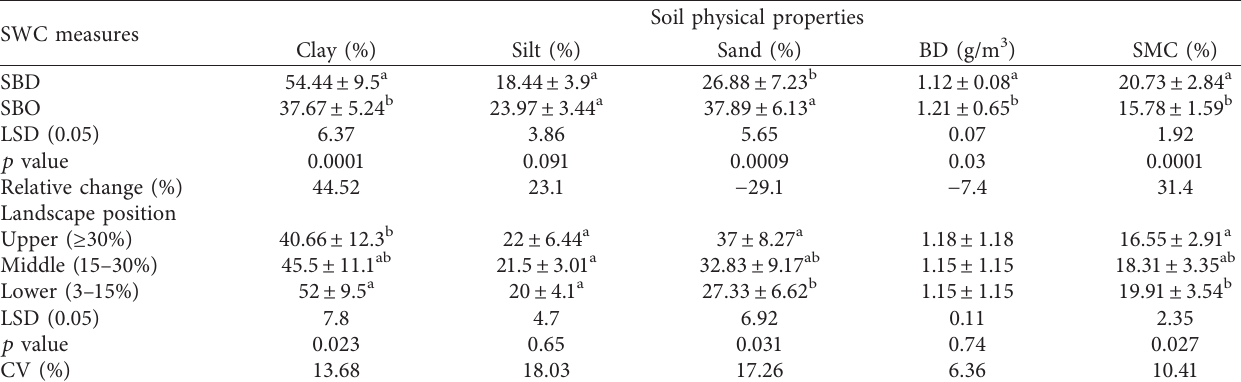
Table 2: The mean effects of soil and water conservation and landscape position on selected soil physical properties (Mean ± SE). SWC